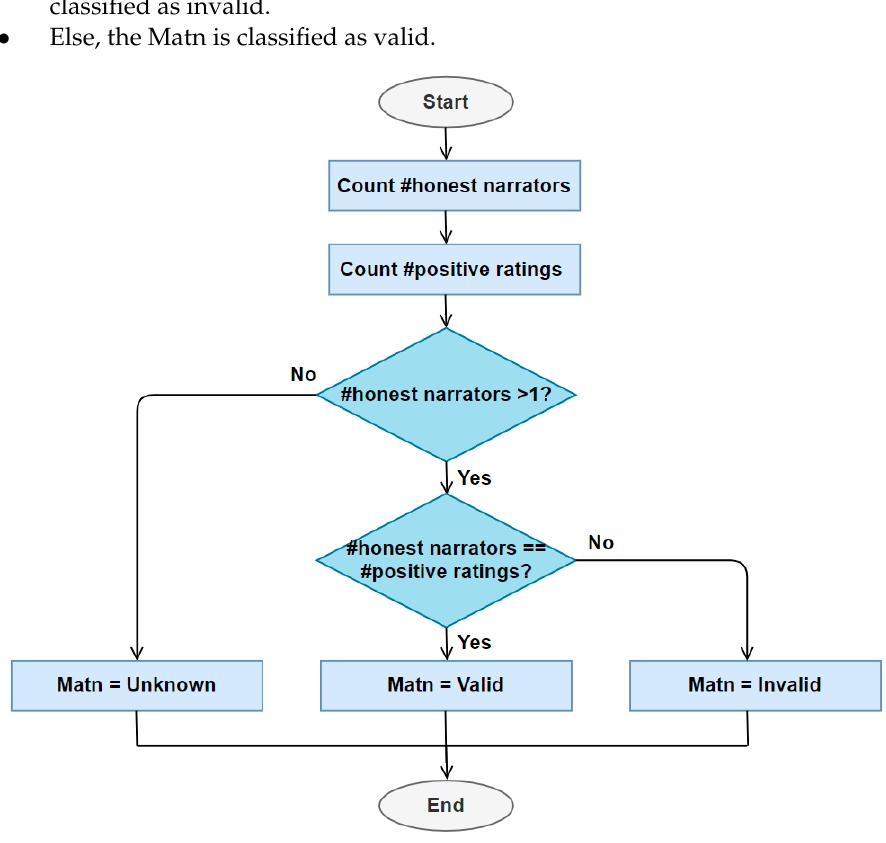
Figure 9. Matn analysis algorithm flowchart.